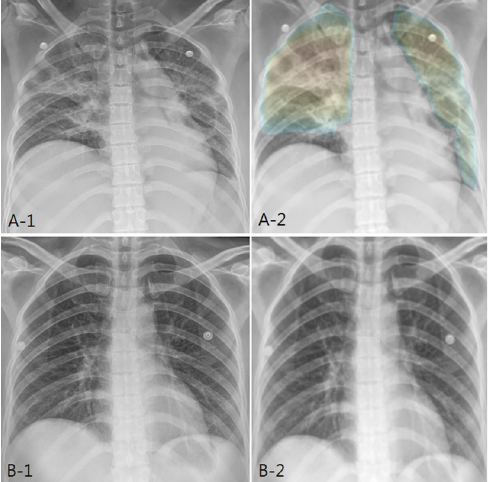
Fig 4. AI probability score changes and heatmap in improved patient. (a) In a 42-year-old female patient, initial chest X-ray shows bilateral patchy increased opacity, compatible with pneumonia. AI pneumonia model (A-2) shows the probability score of 0.787 and color map for pneumonia. (b) After 7 days of treatment, the chest X-ray shows marked improvement. AI pneumonia model (B-2) shows the decrease of probability score (0.318) for